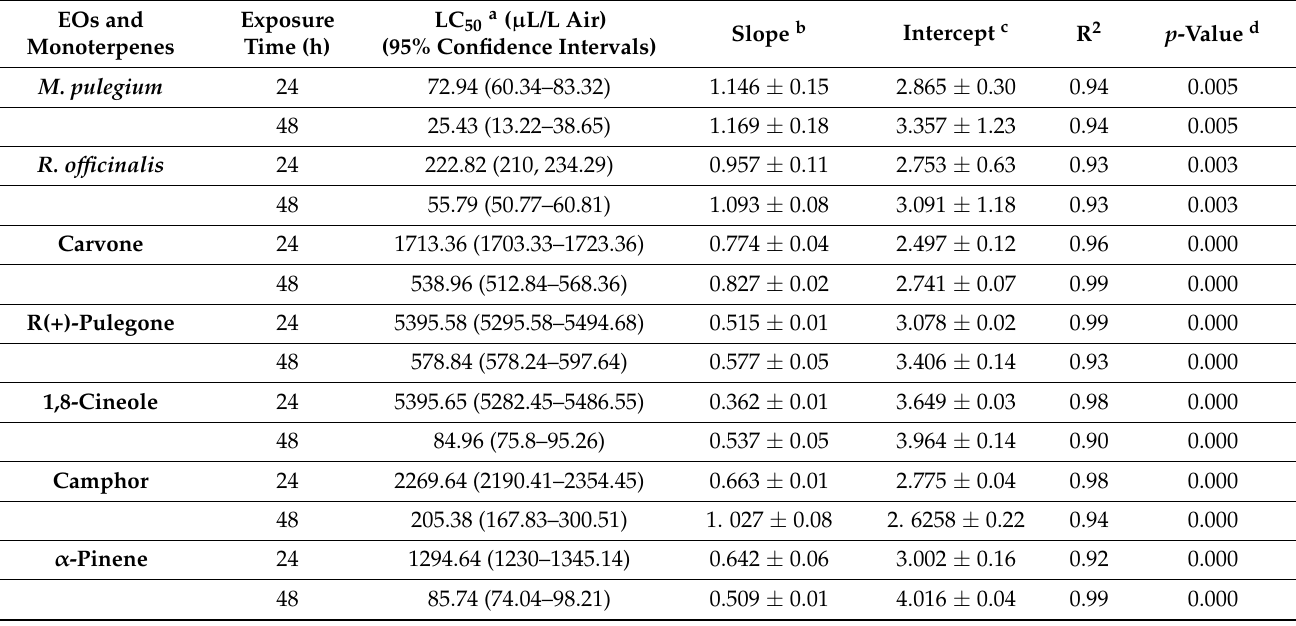
Table 2. Lethal concentrations (LC 50 ) of M. pulegium and R. officinalis EOs and their main